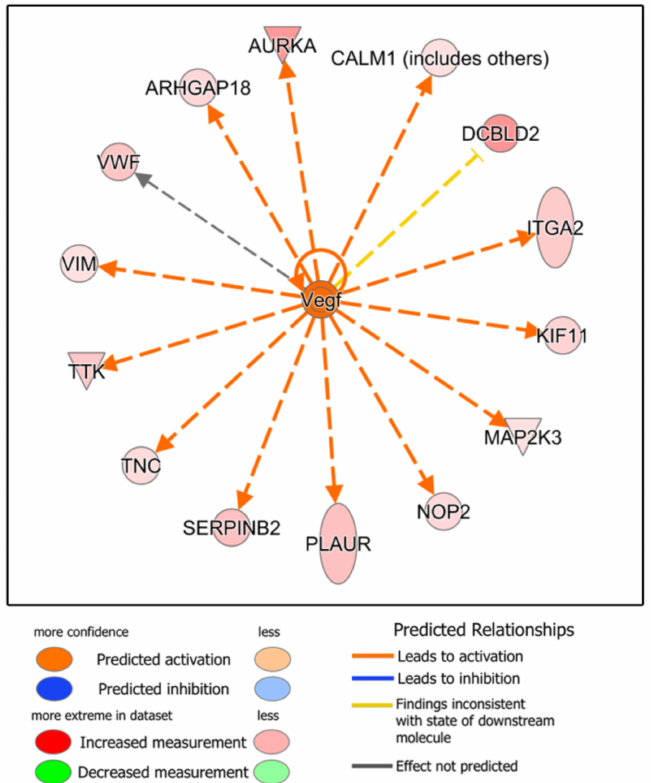
Figure 5. Ingenuity Pathway Analysis (IPA) of deregulated proteins related to vascular endothelial growth factor (VEGF) signaling in human dermal fibroblasts (HDFs) treated with Endoret serum (ES) extract. This figure shows that VEGF could induce the overexpression of at least fourteen proteins.